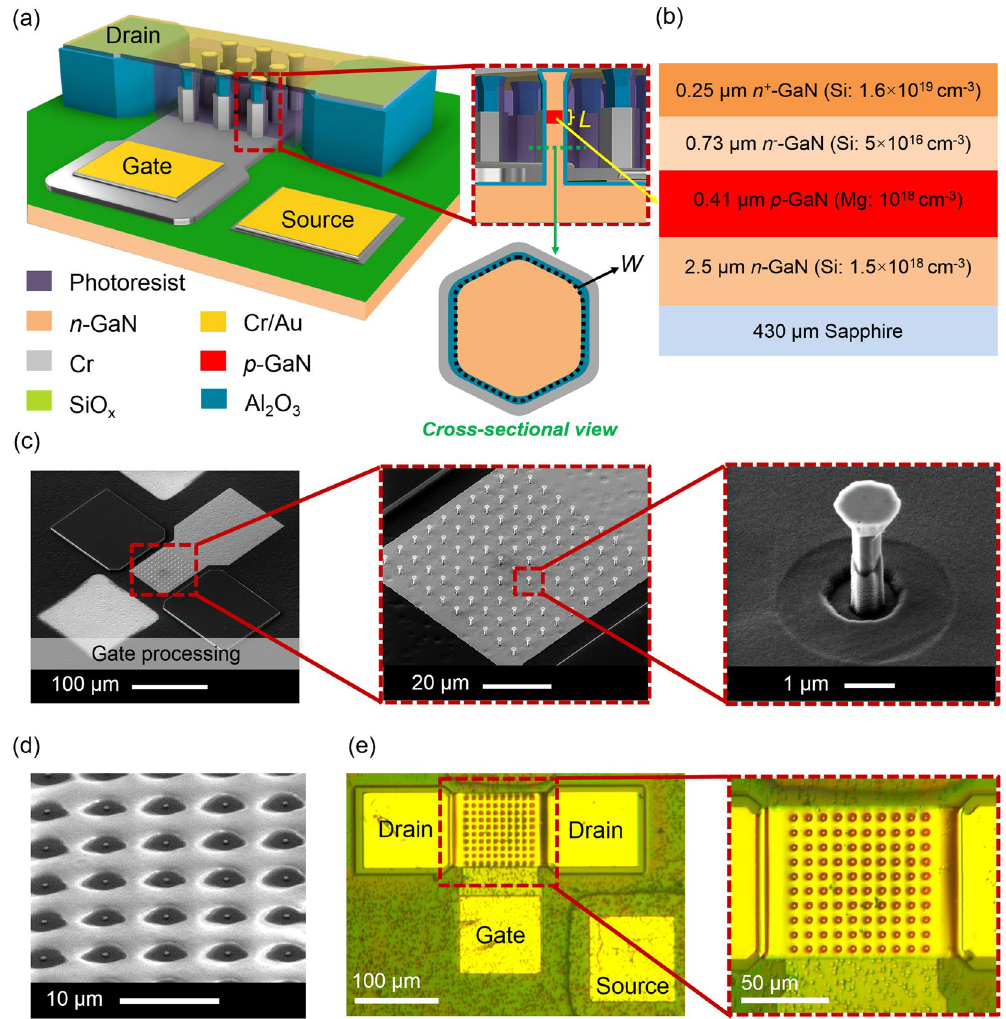
Figure 1. ( a ) 3D schematics of a 9 n-p-n vertical GaN NW FET with L and W as gate length and gate width in inset, respectively, and ( b ) wafer composition used in this work. Fabrication process steps for creating 1, 9, and 100 NW FETs after ( c ) Cr gate processing, ( d ) photoresist filling, short UV exposure, and curing for 30 min at 250 °C, ( e ) e-beam evaporation of Cr/Au (80/200 nm) and subsequent etch-back process to form metal drain contact on n-p-n vertical GaN NW